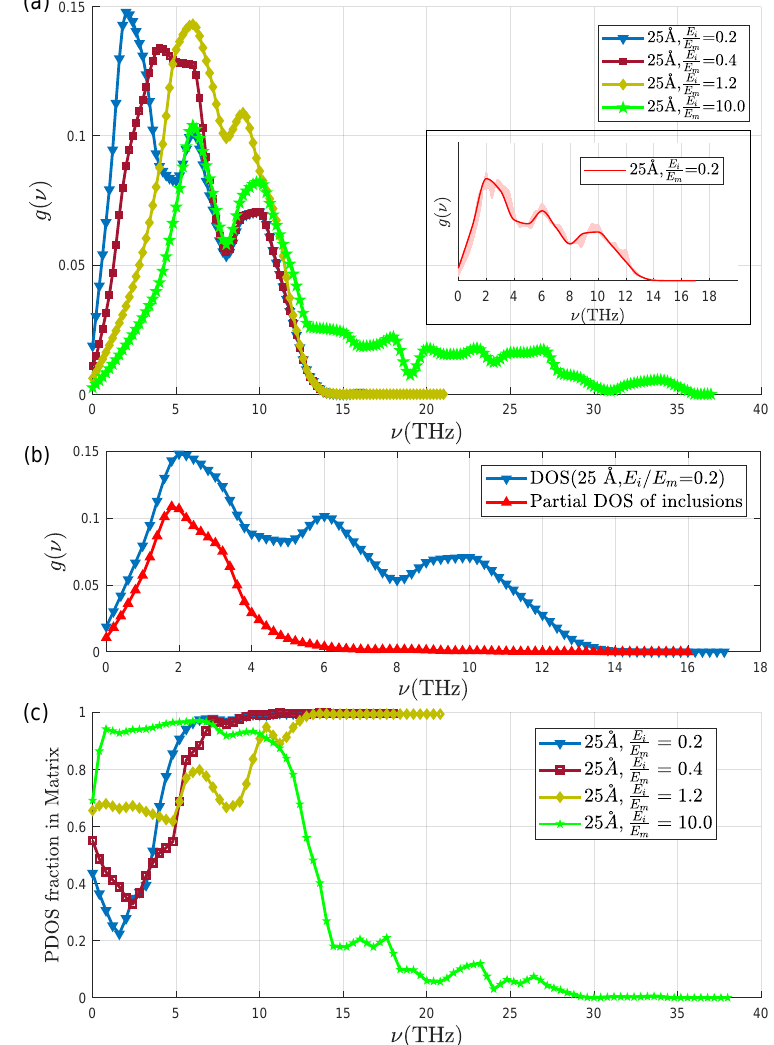
= 0.2,0.4,1.2,10.0 at discrete E m = 0.2 and r = 25 Å. The red line E m = 0.2 ( c ) Fraction of VDOS supported by E m , at discrete frequencies ν with ∆ ν = 1 THz (Triangle, E m = 0.2,0.4,1.2 and 10.0 E m